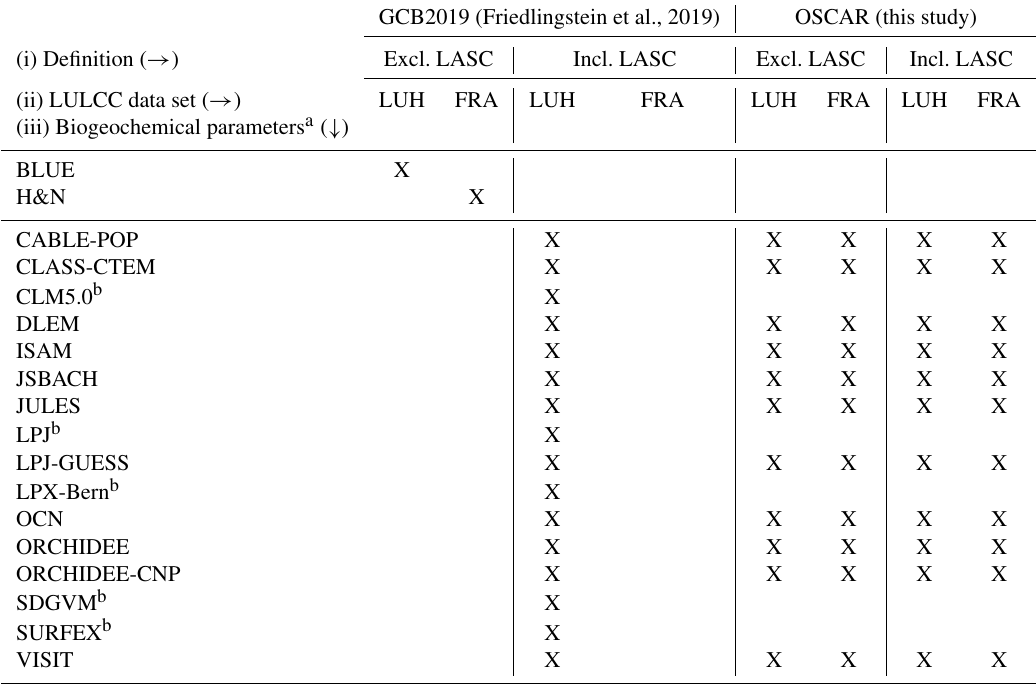
Table 1. Availability of LULCC emissions estimates in the GCB2019 and this study. This follows our three main axes of analysis: the definition of LULCC emissions (i), the driving data sets (ii), and the biogeochemical parameterization (iii). GCB2019 (Friedlingstein et al., 2019) OSCAR (this